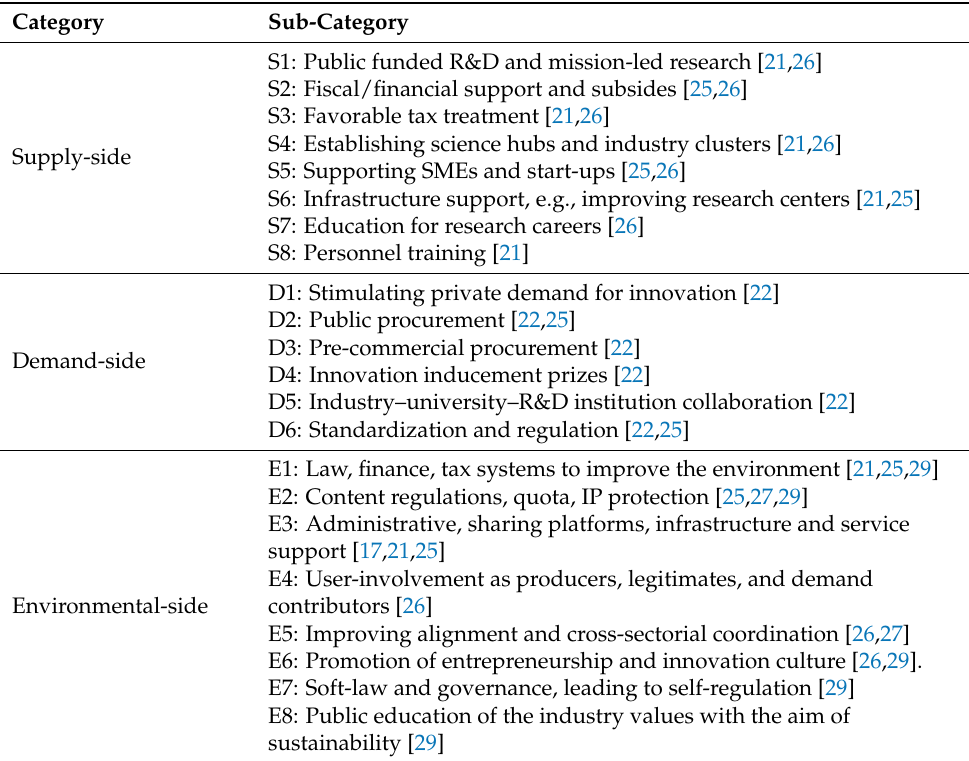
Table 2. Innovation policy